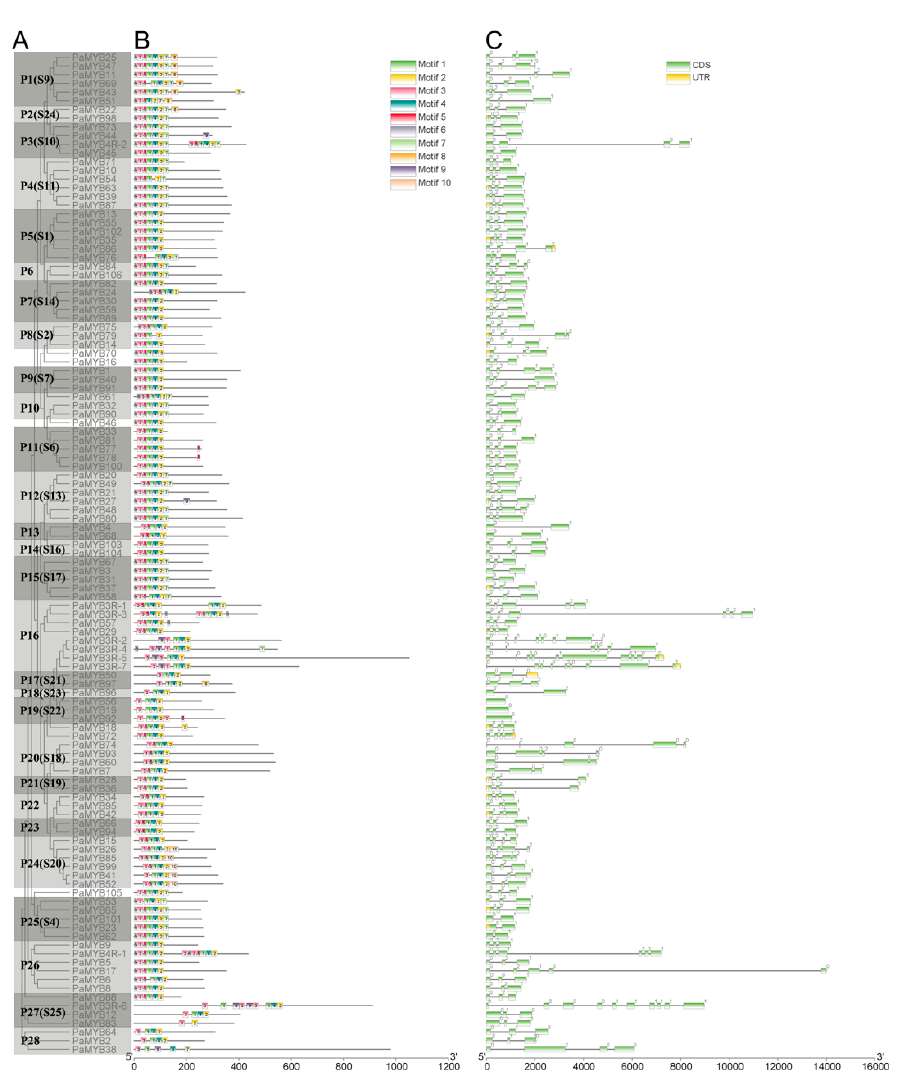
Figure 1. Phylogenetic and gene structure analysis of 2R-, 3R- and 4R-MYB genes in Petunia : ( A ) The phylogenetic tree was constructed with MEGA 10.1.8 using the neighbor-joining (NJ) method with 1000 bootstrap replicates based on a multiple alignment of amino acid sequences of MYB genes. The subgroup was classified and marked by alternated dark and light gray; ( B ) Protein motif. Schematic diagram of the conserved motifs in the MYB proteins, which were elucidated using MEME. Each motif is represented by a number in the colored box. The black lines represent the non-conserved sequences; ( C ) Gene structures of PaMYBs. The exons are represented by green box, the black lines connecting two exons represent introns and untranslated regions are indicated by yellow